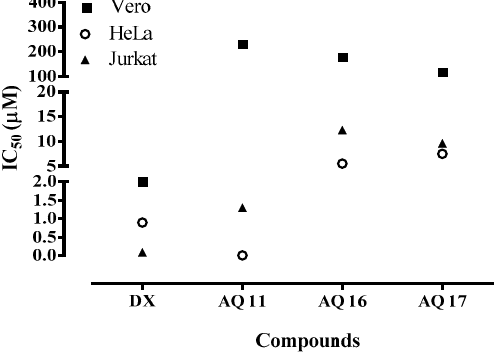
Figure 5. Relative cytotoxicity of the most selective quinones AQ 11 , AQ 16 and AQ 17 for HeLa and Jurkat tumor cells and for normal Vero cells, in comparison with the reference drug doxorubicin